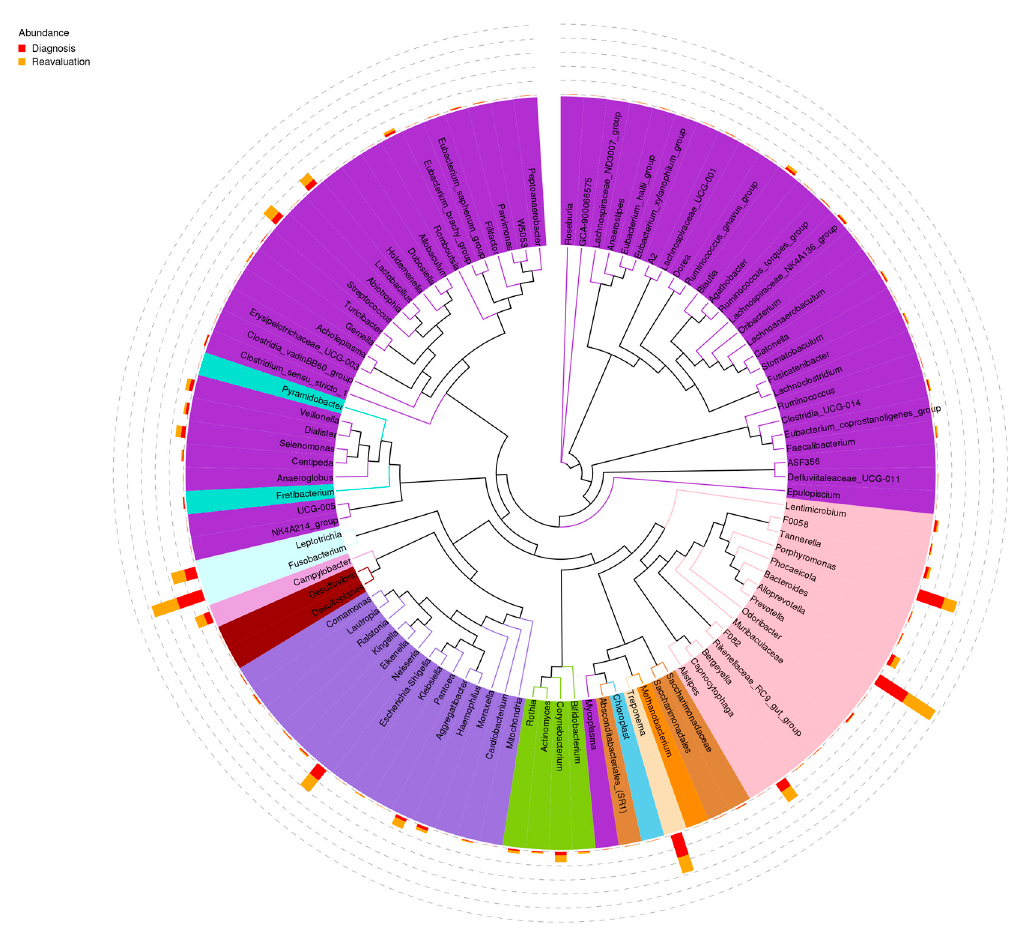
Figure 3. Predominant bacterial species in subgingival plaque. Mean levels of relative abundance of the 100 predominant species in subgingival samples at baseline and 6–8 weeks after treatment.